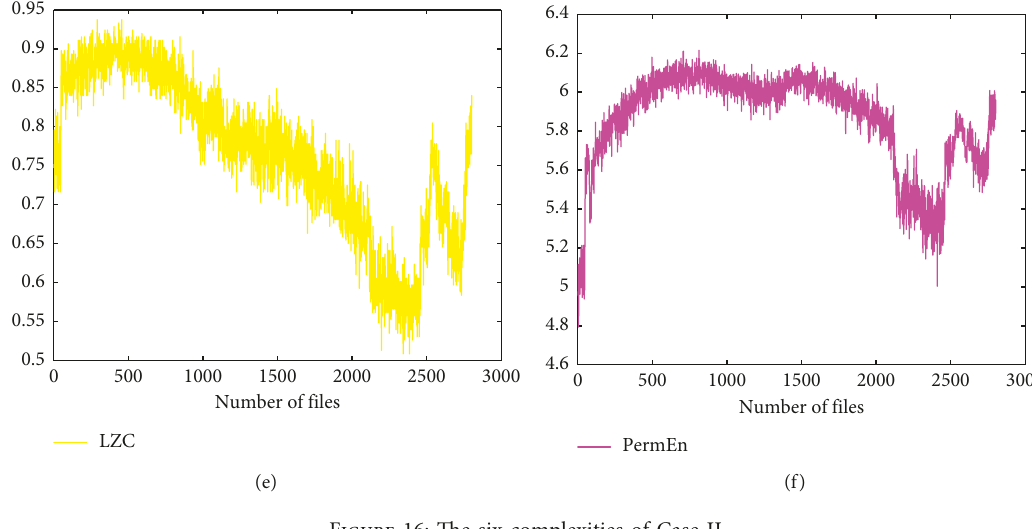
Figure 16: The six complexities of Case